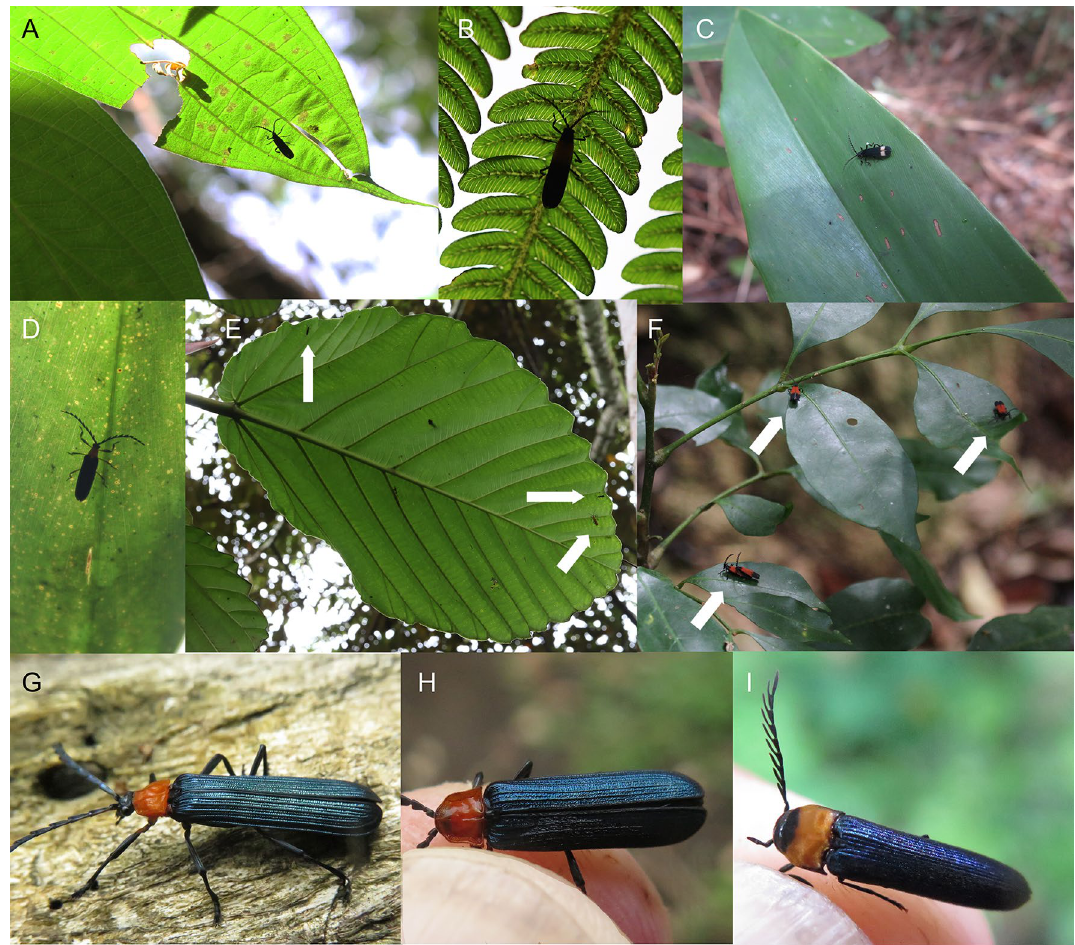
Figure 1. Aposematically coloured Lycidae in nature. ( A ) Microtrichalus sp. on a leaf observed against the clear sky. ( B ) Metriorrhynchus sp. on a fern leaf. ( C ) Metriorrhynchini on an upper side of a leaf. ( D ) Eniclases sp. on a leaf. ( E ) Three differently coloured species of Metriorrhynchini on a single leaf within an aggregation of net-winged beetles. The photographs ( A – E ) were taken in New Guinea. ( F ) The aggregation of Metriorrhynchus sp. in southern Queensland. ( G – I ) The members of the orange/metallic mimicry ring in the northern Sulawesi: ( G ) Metriorrhynchus sp.; ( H ) Plateros sp.; ( I ) Eucnemidae indet. All photographs and drawings by authors listed under the title of this